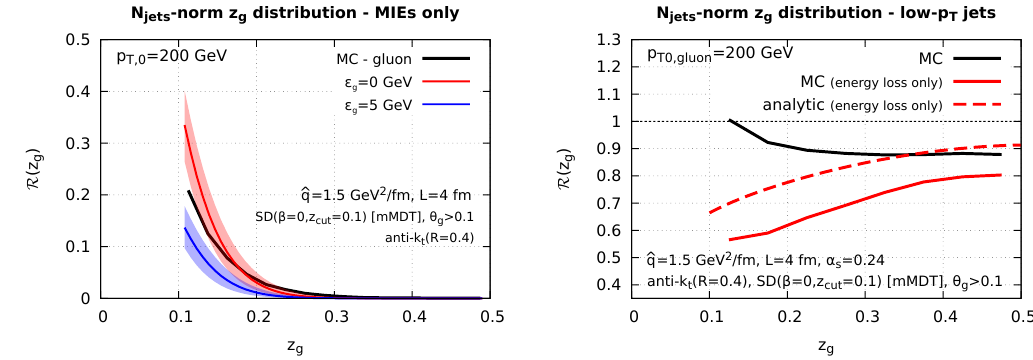
Figure 15 . Separation of the nuclear e(cid:11)ects on the z g distribution of low-energy jets into a contribution due to the MIEs (left) and a contribution due to the VLEs with energy loss (right). Left: MIEs only (MC vs. analytic calculations). Right: Monte Carlo results for the full parton shower (black) vs. the case where only VLEs with energy loss are included (red). We also show an analytic result for the second case (dashed